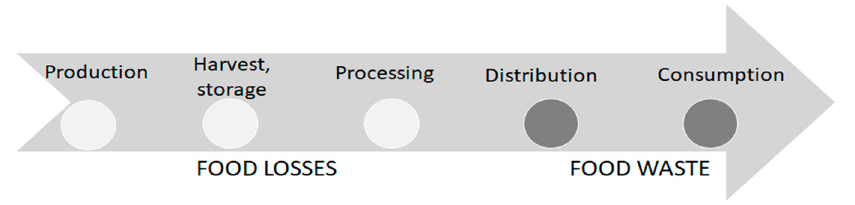
Figure 1. Food loss and waste according to their position in the supply chain. Source: based on Parfitt et al. [11]; Food and Agriculture Organization (FAO) [10], own